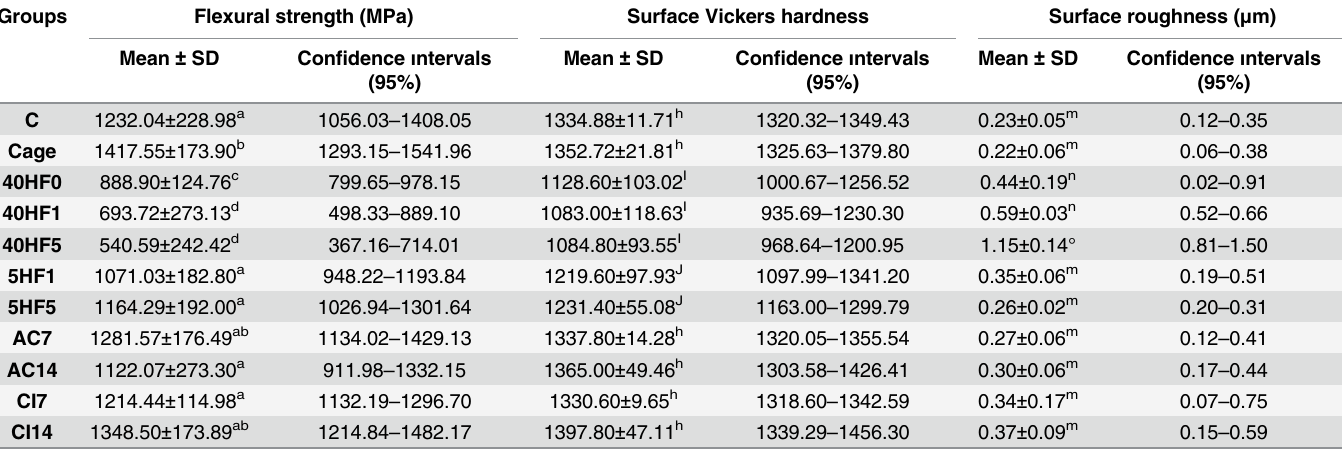
Table 2. Flexural strength, Vickers hardness, and surface roughness values for each group.